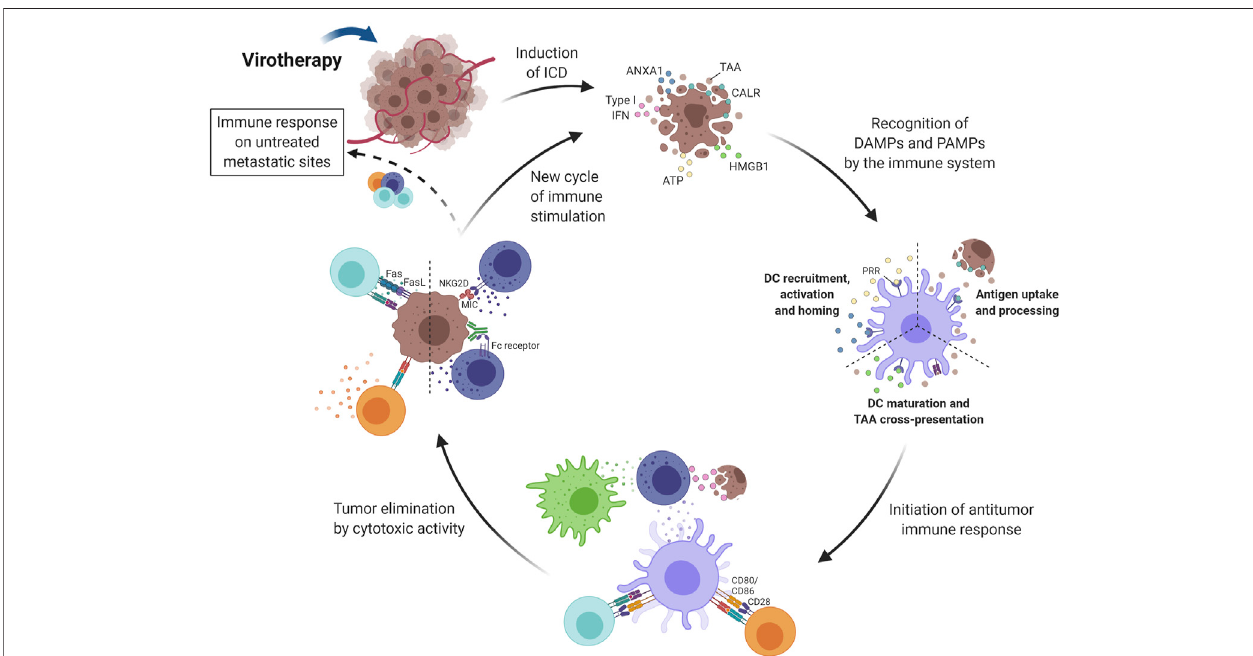
FIGURE 3 | Induction of immune activity in response to virotherapy. Virotherapy can induce ICD, which is characterized by the release of DAMPs (i.e., CALR, HMGB1,ANXA1andtypeIIFN)duringcelldeath.Thesedangersignals,alongwithTAAsandPAMPsalsoreleasedbyOV-treatedtumorcells,promotetheinitiationofan immune response after recognition by antigen-presenting cells (mainly DCs). ATP and ANXA1 are responsible for DC recruitment, activation and homing; CALR increases antigenuptake and processing; and HMGB1promotes DCmaturation and antigencross-presentation.Next, TAAsarepresented toTlymphocytesthat candifferentiateintoboth helperandcytotoxiccellssincepresentationoccursbyclassIandIIMHCproteins. Thecytotoxicactivity ofNKcellsisalsoimportantfortumor elimination and type I IFNs play an important role in their stimulation together with signals provided by activated DCs and macrophages. Activated effector cells are then capable of recognizing and eliminating tumor cells by different mechanisms, for example, Fas-FasL interaction with CD8 + T lymphocytes and MHC recognition by the NKG2D receptor on NK cells. Another key advantage of activating the immune system relies on the possibility of reaching untreated metastatic sites through circulating immunecells.Thecyclerestartsasdyingtumorcellsreleasemoreantigensandintracellularmoleculesthatkeeponactivatingtheimmunesystem.DC,Dendriticcell;NK, Natural killer; T reg , Regulatory T cell; ICD, Immunogenic Cell Death; TAA, Tumor-Associated Antigen; CALR, Calreticulin; HMGB1, High Mobility Group Box-1; ATP, AdenosineTriphosphate; IFN, Interferon; ANXA1, Annexin A1;DAMPs, Damage-Associated Molecular Pattern; PAMPs, Pathogen-Associated Molecular Pattern; PRR, Pattern Recognition Receptor; NKG2D, Natural Killer Group 2D; OV, Oncolytic Virus; MHC, Major Histocompatibility Complex. Created with